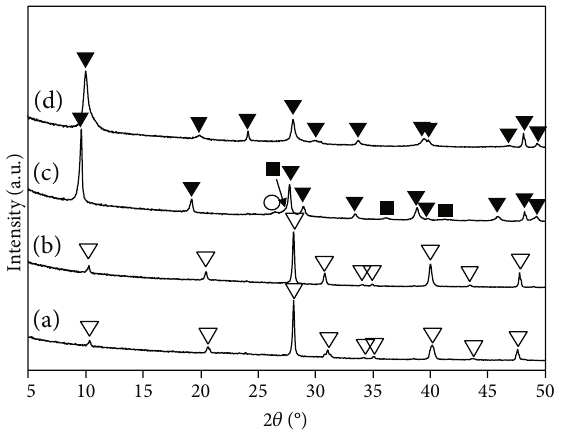
Figure 1: XRD patterns of (a) CTNO (0)_800, (b) CTNO (0.05)_ 800, (c) HTNO (0)_800, and (d) HTNO (0.05)_800: ▽ : Cs □ □ Ti O , ▼ : H Ti O , ■ : TiO (rutile), and ○ : 1 : 825 0 : 175 4 0.7 1.825 0.175 4 2 unknown.